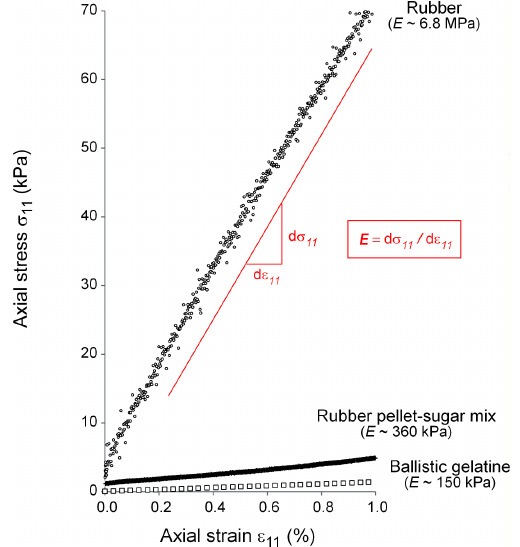
Figure 6. Elastic moduli of selected rock analogue materials as measured in an axial tester. Data and methodological details are published as open-access material in Rosenau et al.